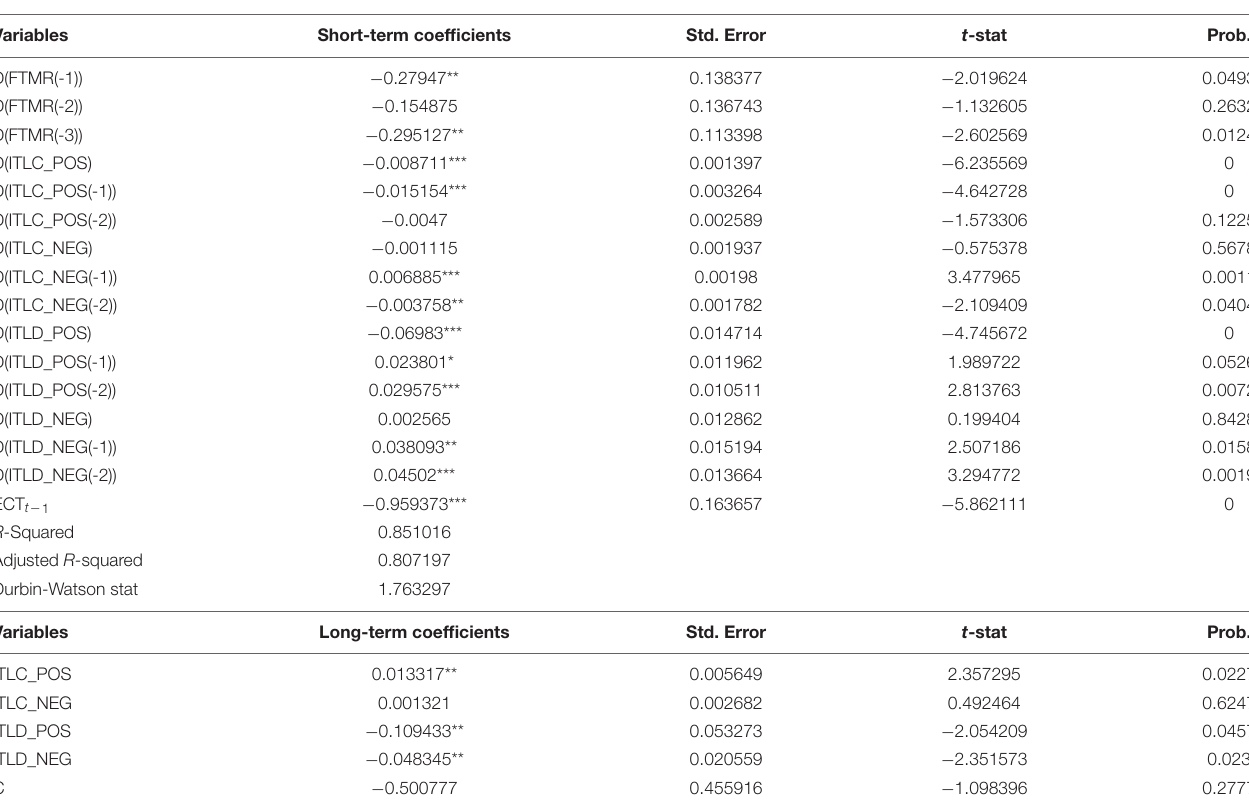
TABLE 8 | Asymmetric parameters of